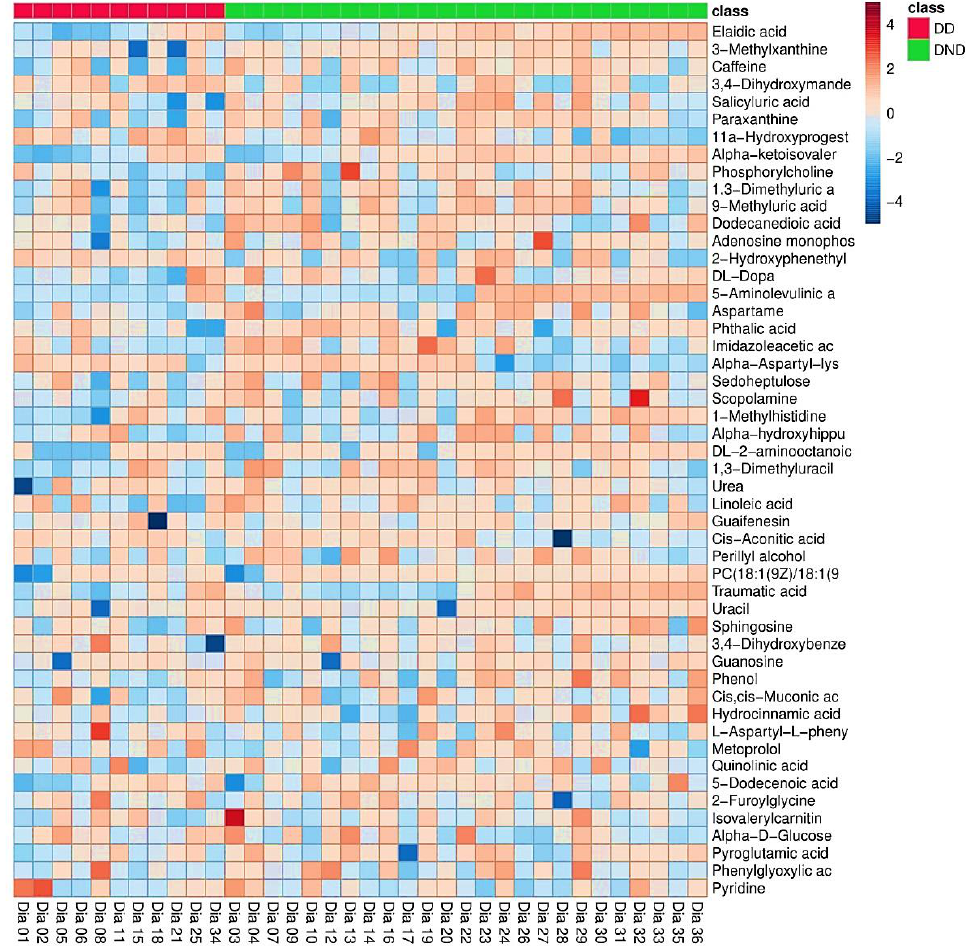
Figure 1. Heatmap of the 50 selected metabolites among the DD and DND patients (clinically con- firmed diabetic status). The columns represent samples, the rows represent metabolites, and the relative content of the metabolites is displayed by color. The heatmap shows detected metabolites among DD and DND groups.